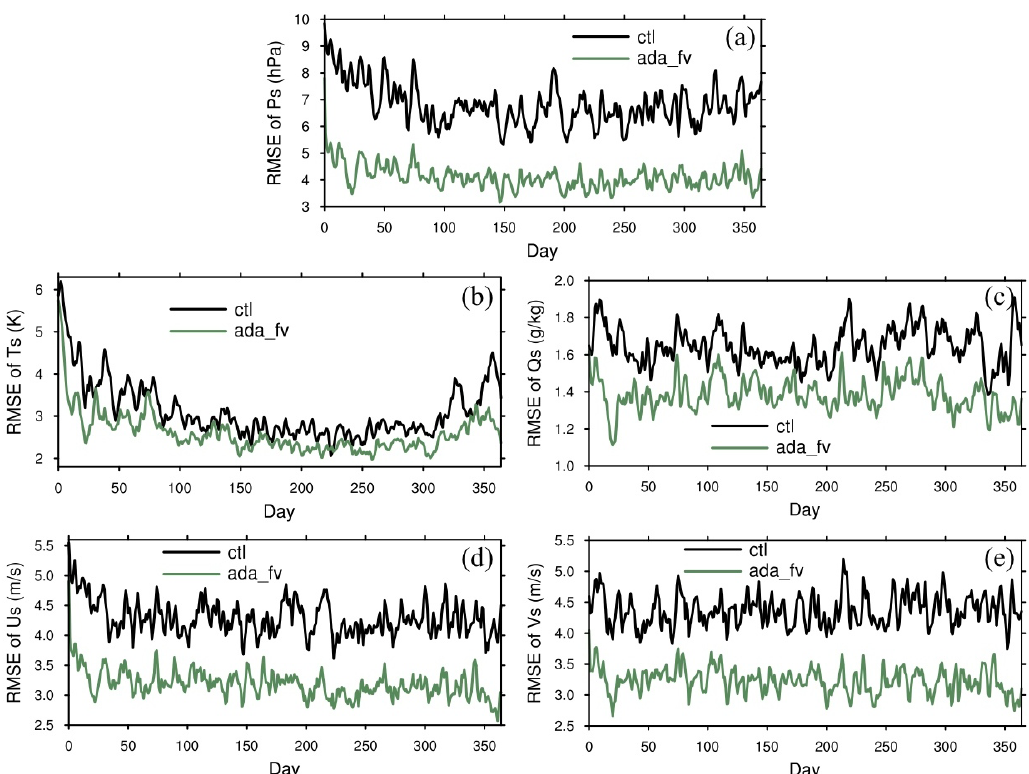
Figure 4. Time series of RMSEs of (a) surface pressure P s , (b) surface temperature T s , (c) surface specific humidity Q s , (d) surface zonal wind U s , and (e) surface meridional wind V s from ctl and ada_fv.